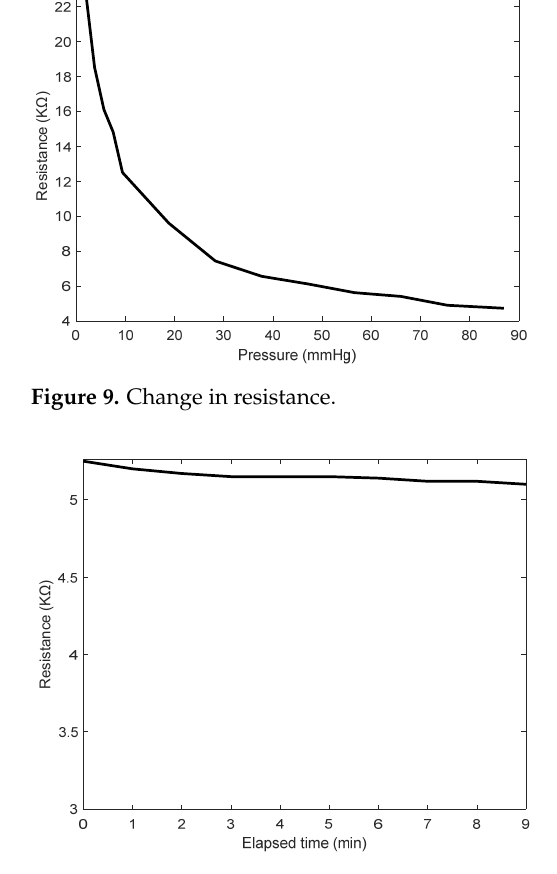
Figure 10. Resistance drift.